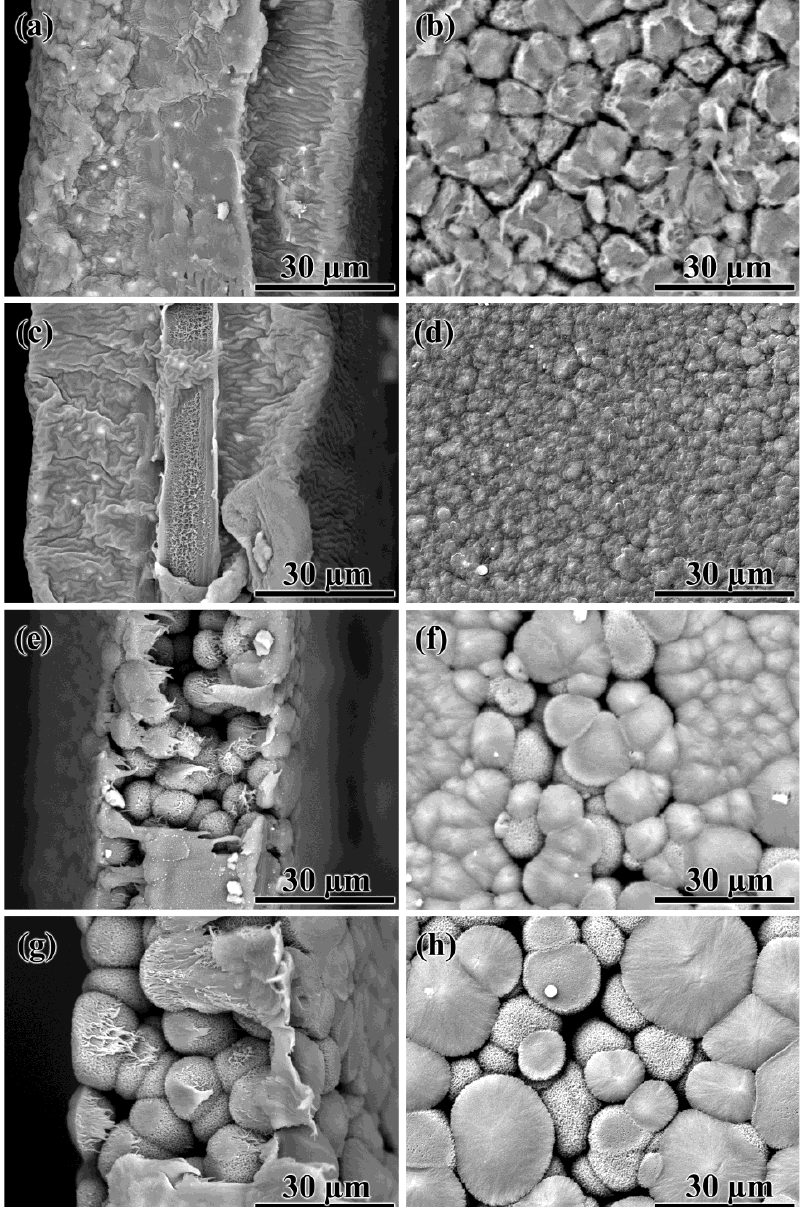
Figure 9. SEM images of the cross-sections ( a , c , e , g ) and surfaces ( b , d , f , h ) of the porous films obtained from 20% ( a , b ), 30% ( c , d ), 35% ( e , f ), and 40% ( g , h ) polylaurolactam solutions by its precipitation with isopropanol.